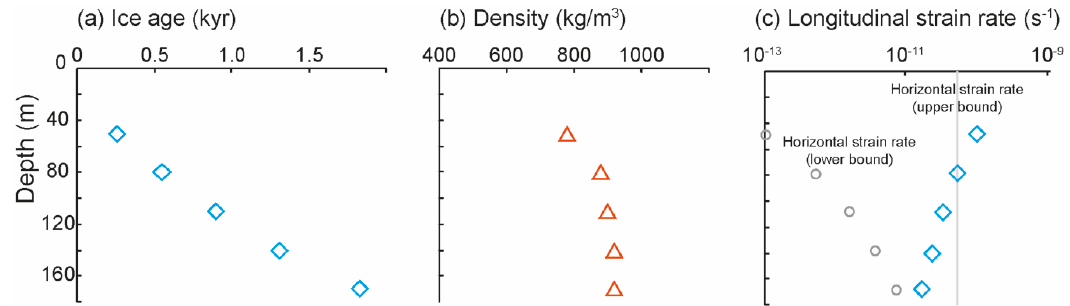
Figure 4. Plots of ( a ) ice age, ( b ) density, and ( c ) longitudinal strain rate as a factor of increasing depth. ( a ) The ice age of the core was derived from Yang et al. [44]. ( b ) Density is computed from the measured weight of the core divided by volume. ( c ) Longitudinal strain rate is calculated from density divided by time. Upper and lower bound horizontal strain rates are presented as a grey line.